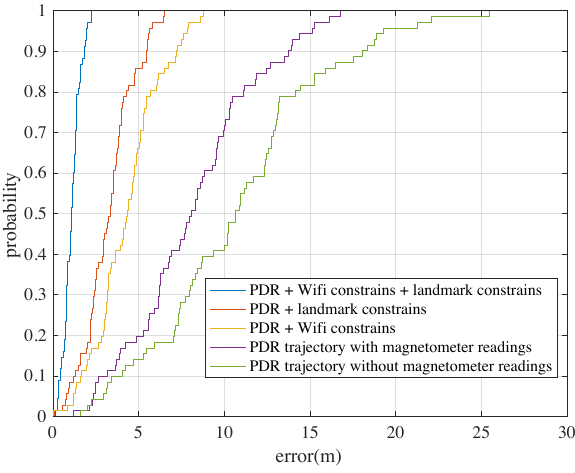
Figure 11. The CDFs of positioning errors at the test